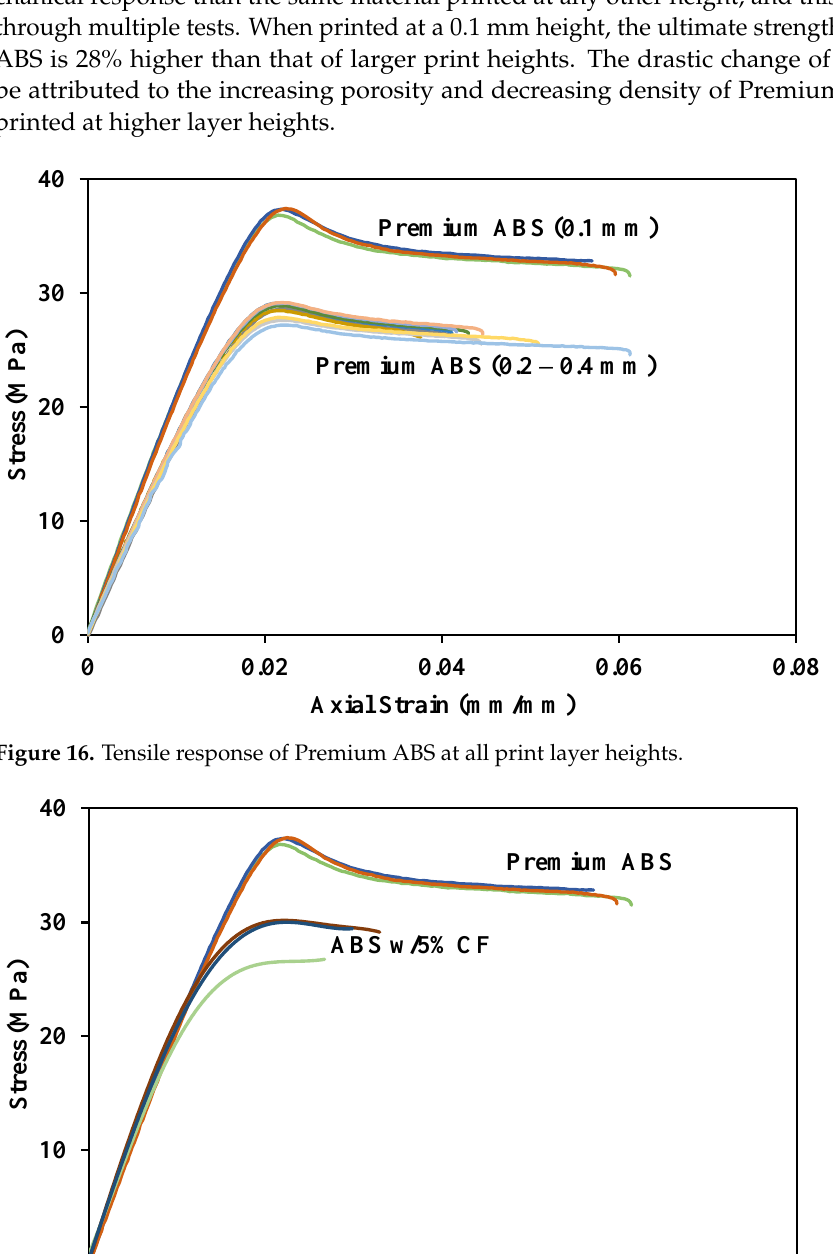
Figure 15. Ultimate strength of ABS materials as a function of layer height.